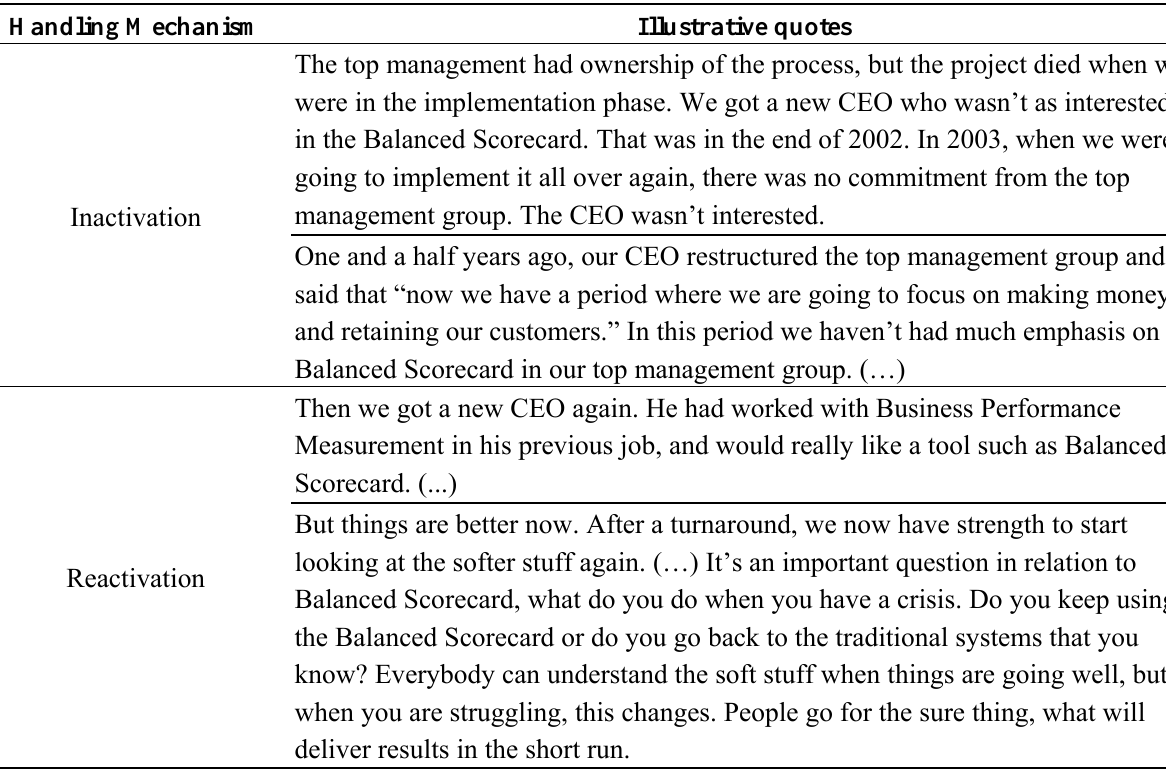
Table 12. Dormancy of the